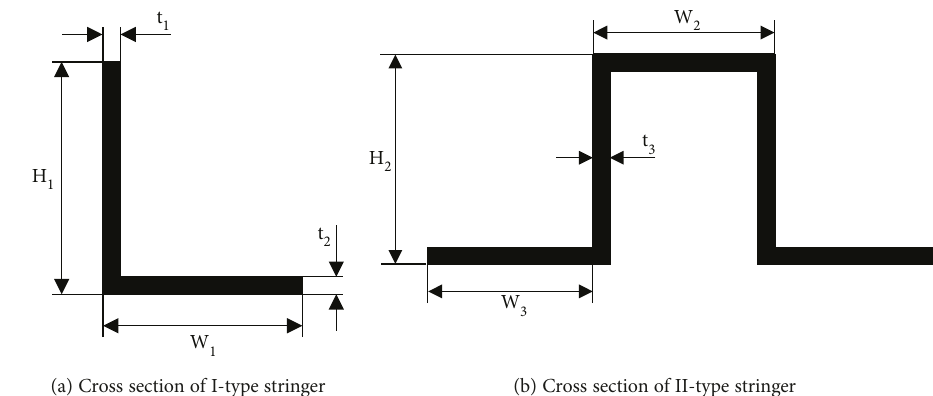
Figure 3: Cross sections of I-type stringer and II-type stringer.